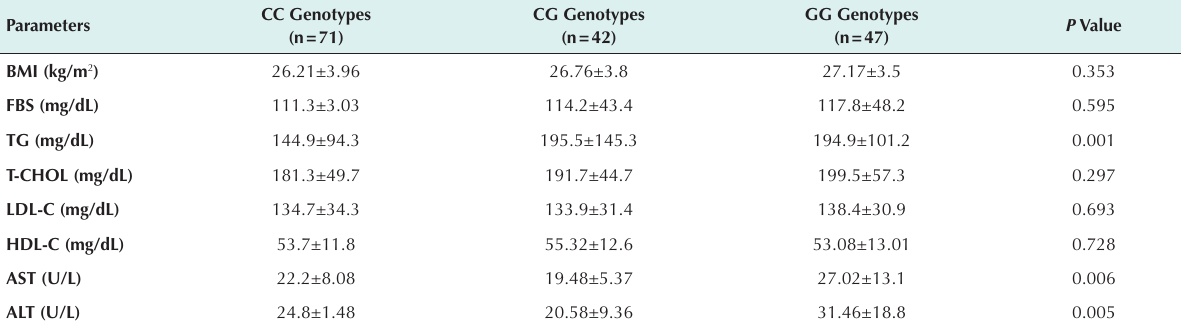
Table 3. Demographic and Clinical Characteristics Between CC, CG, and GG